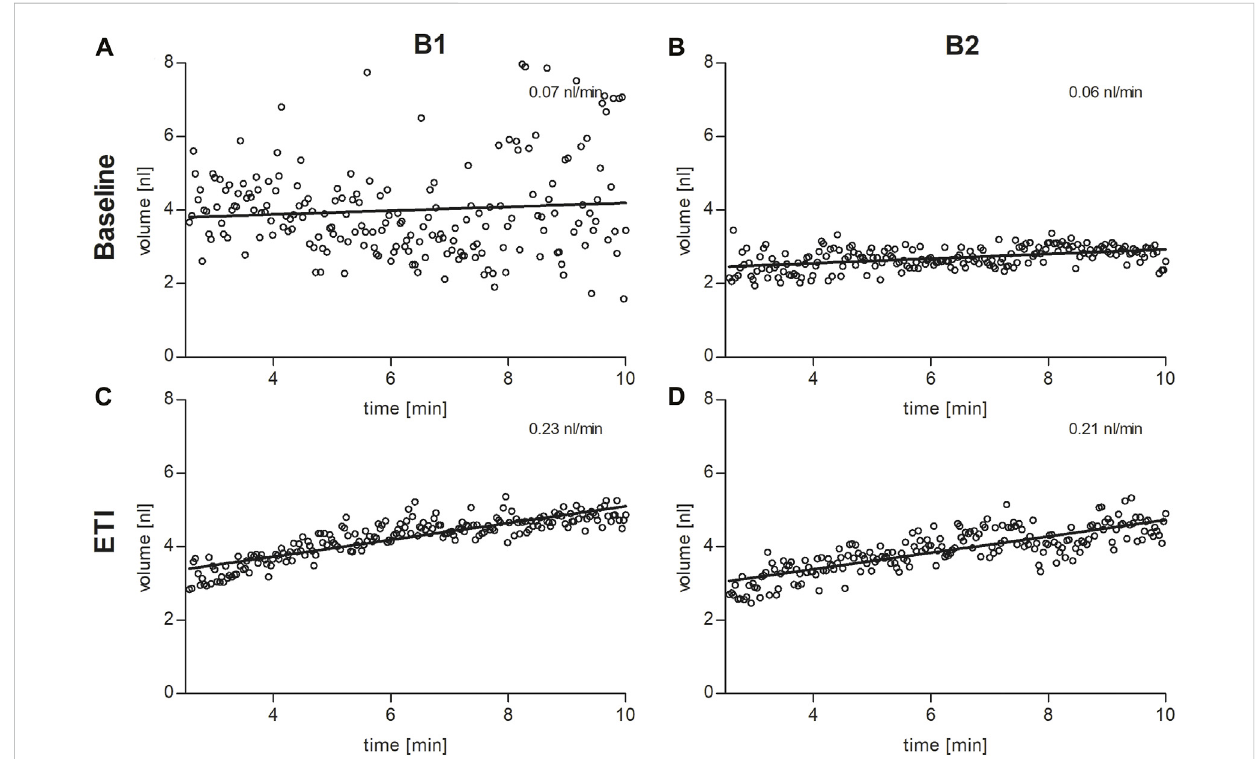
FIGURE 2 Sweat bubble formation after β -adrenergic stimulation of the skin at baseline (A,B) and under ETI (C,D) in brother 1 (B1, left column) and brother 2 (B2,rightcolumn).EachdotrepresentsthemedianbubblevolumepertimepointascalculatedbytheAutoBuSTeDsoftware(Pallenbergetal.,2022).The line shows the linear correlation, the slope corresponds to the sweat rate in